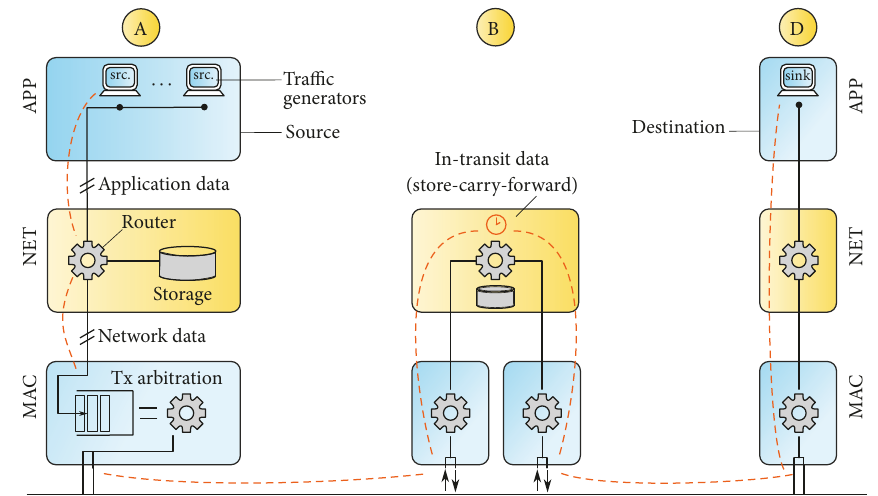
Figure 5: DTN node architecture in